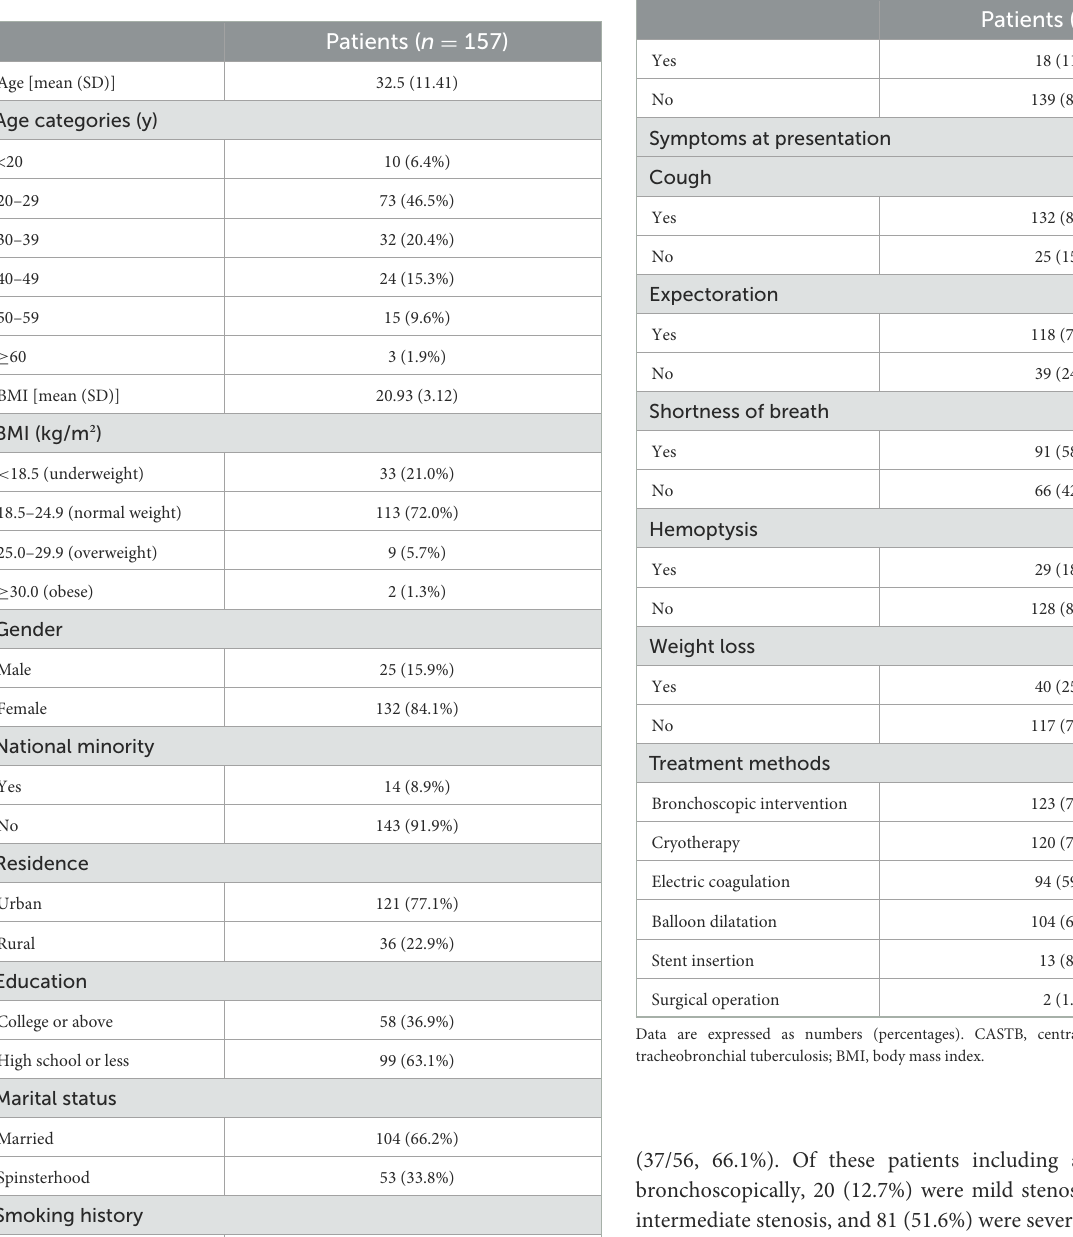
TABLE 1 Demographic and clinical characteristics of 157 patients diagnosed with CASTB.